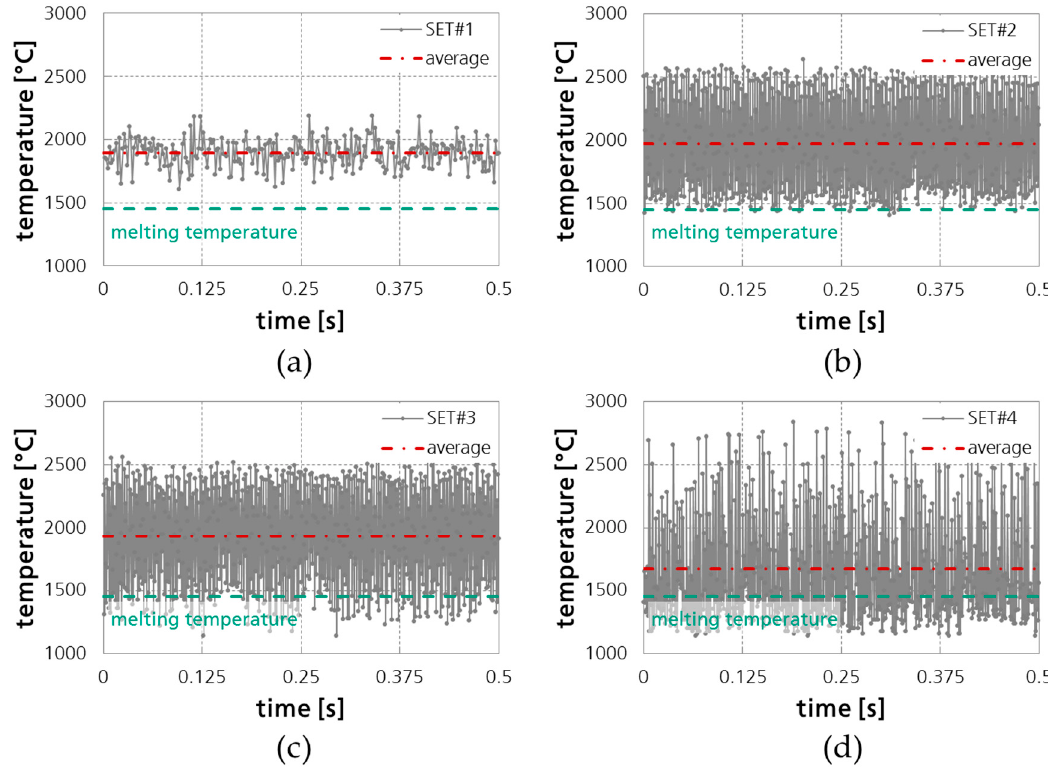
Figure 18. Temporally resolved temperature sequences at the position of the submatrix T p,p ( t ) in Figure 16 of 12 mm stainless steel cut with: ( a ) Set #1: Static beam shaping; and different values of the longitudinal, linear beam oscillation parameters: ( b ) Set #2: 300 µ m amplitude and 500 Hz frequency; ( c ) Set #3: 550 µ m amplitude and 500 Hz frequency; ( d ) Set #4: 300 µ m amplitude and 2000 Hz frequency.